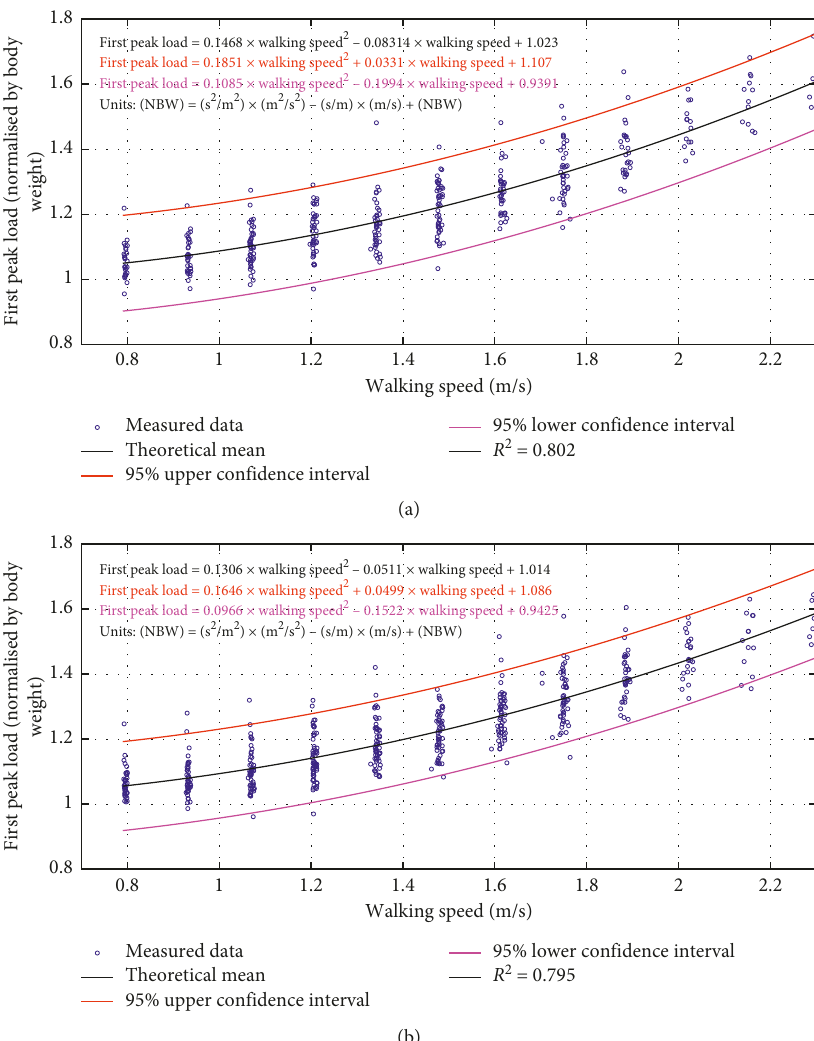
Figure 7: Statistical relationship between walking speed and first peak load. (a) Right footfall; (b) left footfall. 0.20.40.60.811.2